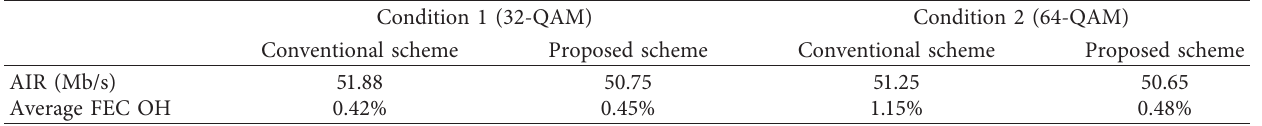
Table 2: AIR performance comparison in the